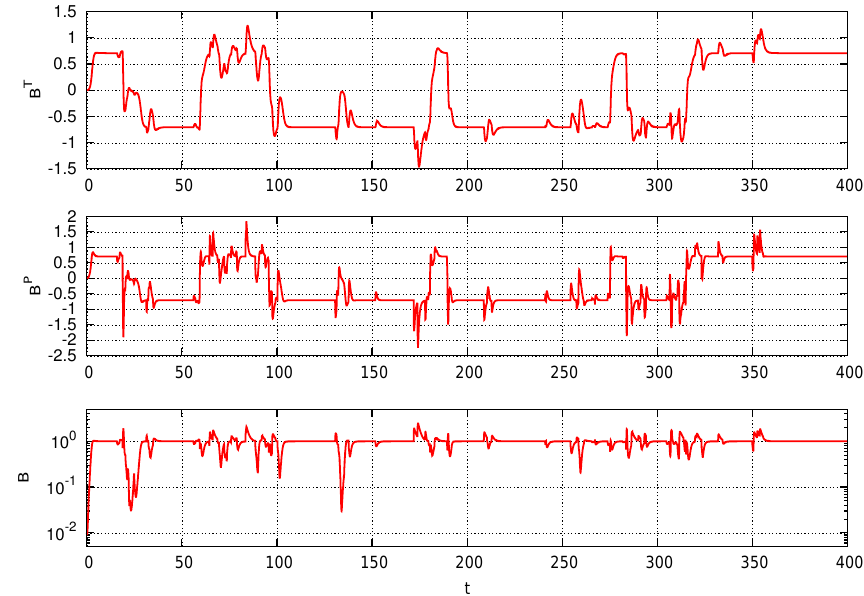
Figure 2. The segment of the magnetic field realization for ε = 5, γ = 2 . 5: the toroidal component of B T , the poloidal component of B P , p | B T | 2 +| B P | 2 (log scale). field value of B =